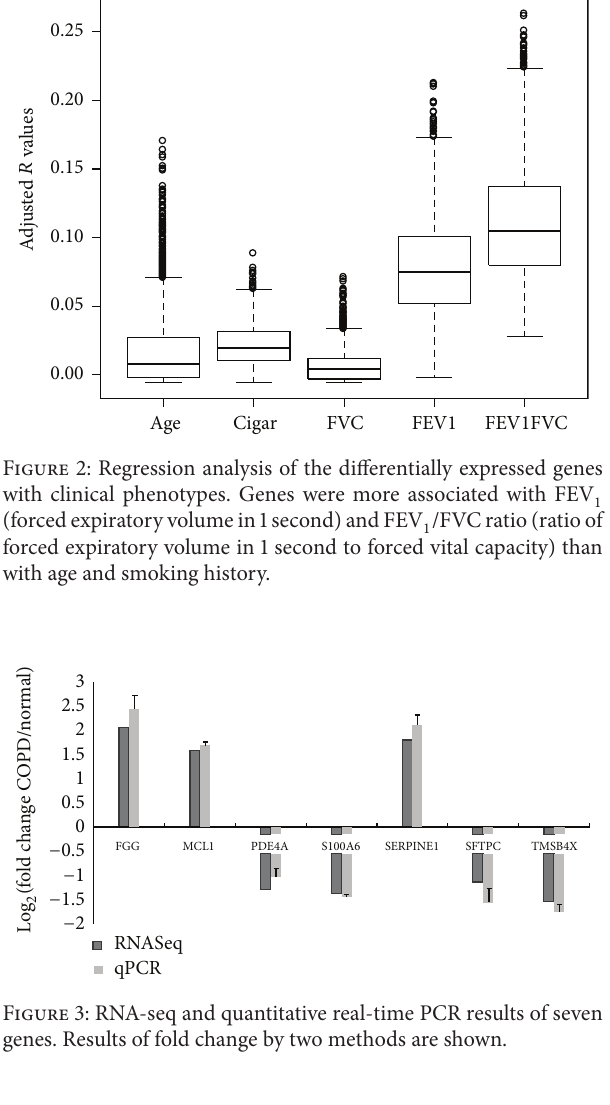
Table 1: Demographics of COPD subjects and control subjects with normal lung function.